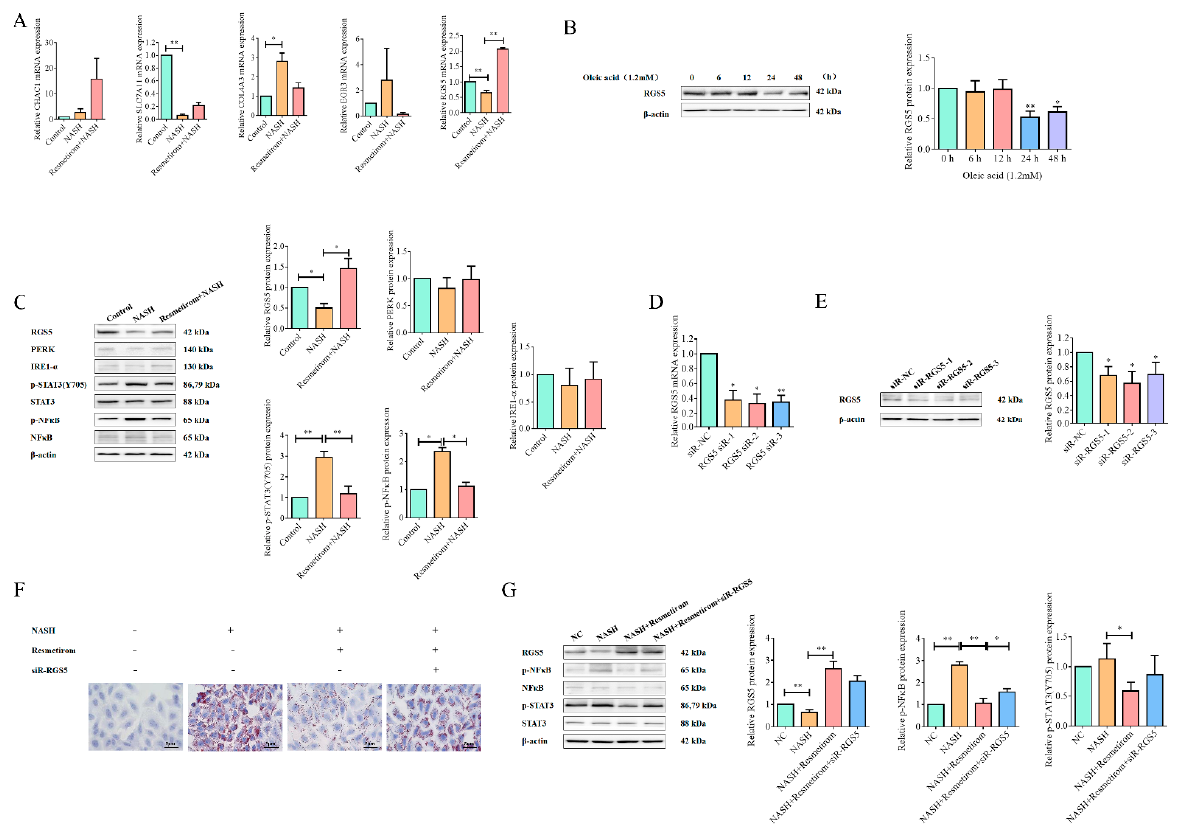
Figure 3. Resmetirom might ameliorate NASH in an RGS5-dependent manner. ( A ) The expressions of the top five DEGs were further validated by qPCR. ( B ), HepG2 cells were treated with indicated concentrations of oleic acid for 48 h, Western blot assay was used to determine the expression of RGS5 protein. The protein level was analyzed and is presented in the histogram in the right panel. ( C ), HepG2 cells were pre-incubated with 0 or 100 µ M resmetirom for 48 h, followed by treatment with 0- or 1.2-mM oleic acid for another 48 h, and the indicated protein expressions were determined by Western blot assays. The protein level was analyzed and is presented in the histogram in the right panel. ( D ), HepG2 cells were transfected with RGS5 siRNA or NC siRNA for 24 h, and qPCR experiment was performed to examine the silence efficiency. ( E ), Total proteins were extracted in cells treated as in ( D ), and Western blot assay was performed to detect the RGS5 expression. The protein level was analyzed and is presented in the histogram in the right panel. ( F ), HepG2 cells were pre-incubated with 0 or 100 µ M resmetirom for 48 h and transfected with RGS5 siRNA-2 or NC for 24 h, followed by treatment with 0- or 1.2-mM oleic acid for another 48 h, and Oil red O staining experiment was performed to determine the cellular lipid accumulation. ( G ), Total proteins were extracted in cells treated as in ( F ), and Western blot assay was performed to detect the expressions of the indicated proteins. The protein level was analyzed and is presented in the histogram in the right panel. Data are presented by mean ± SD for three independent experiments. * p < 0.05; ** p < 0.01 vs.